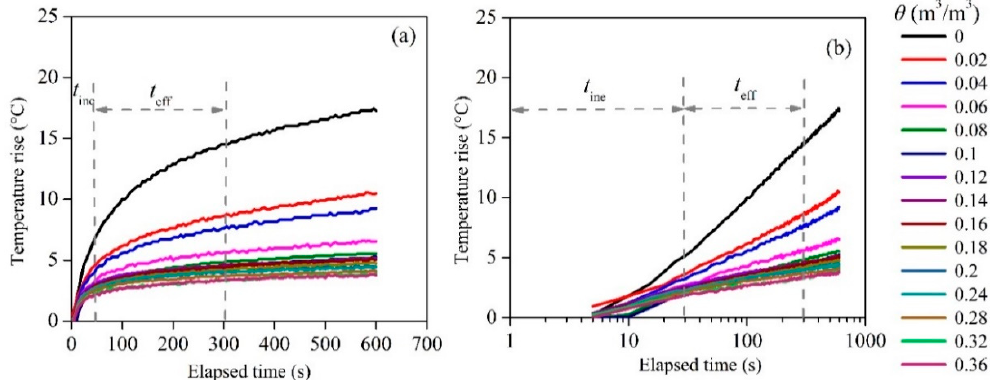
Figure 5. Temperature response versus the elapsed time: ( a ) average temperature response of the ATPS, and ( b ) relationship between the temperature rise and logarithmic time. t eff is the effective time period, t ine is the ineffective time period, and θ is the soil moisture content.